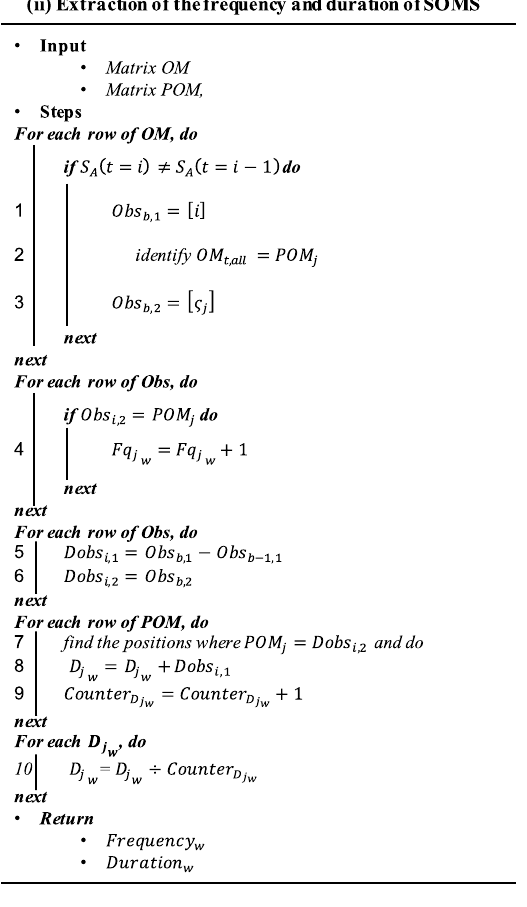
Figure 3. Pseudo-algorithm of step ii.